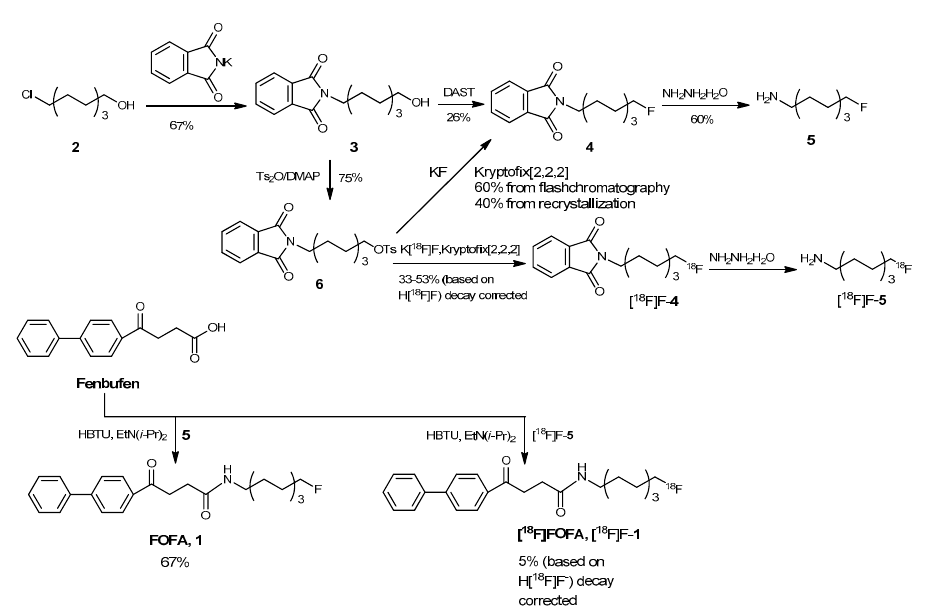
Scheme 1. Schematic depiction of the preparation of target [ 18 F]FOFA ([ 18 F]F- 1 ) and the reference non-radioactive standard FOFA ( 1 ).